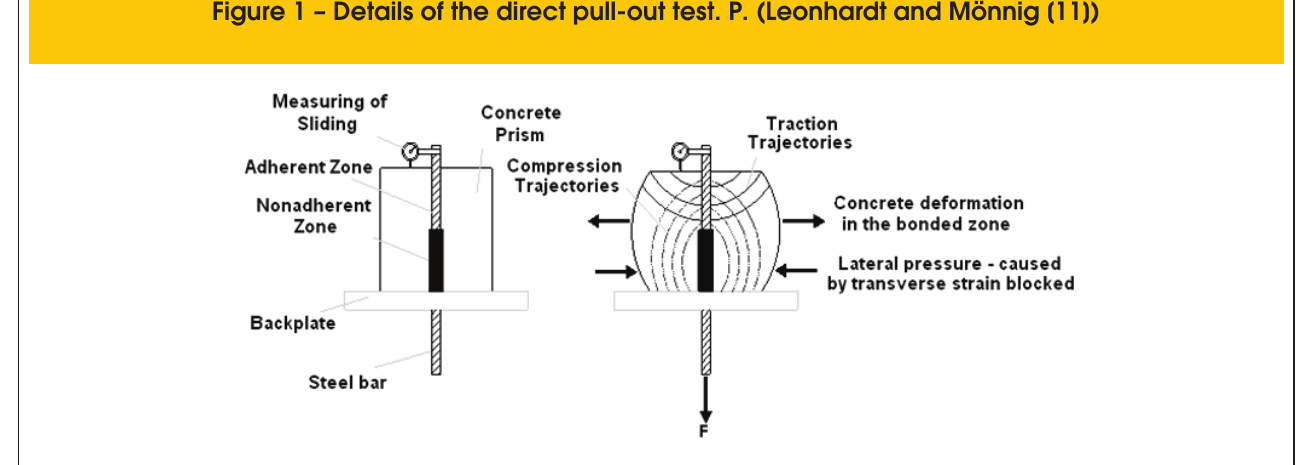
Figure 1 – Details of the direct pull-out test. P. (Leonhardt and Mönnig